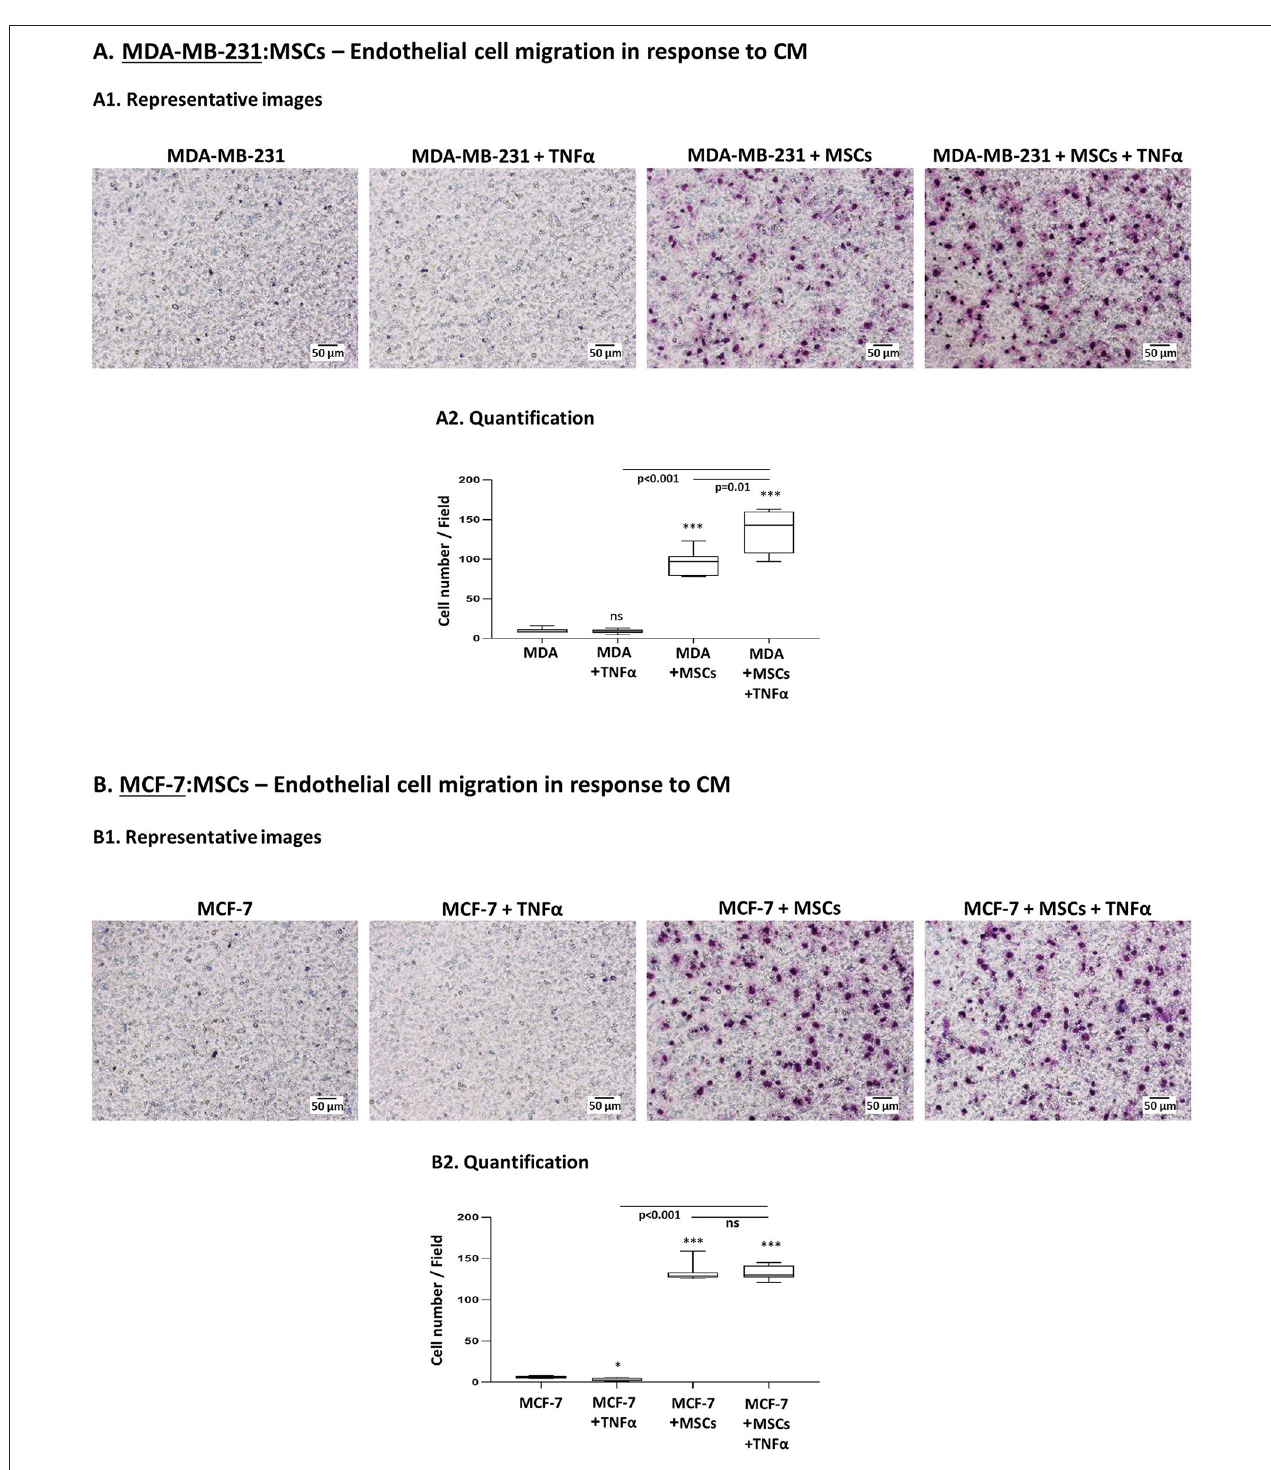
FIGURE 8 | The pro-angiogenic activities of factors released by tumor:MSC “Contact” co-cultures are promoted by TNF α in TNBC but not in luminal-A cells. Studies of endothelial cell (HPMEC) migration in response to CM derived from different cell combinations of MDA-MB-231 cells (“MDA”) (A) and MCF-7 cells (B) . (A1, B1) Representative photos of HPMEC migration in response to TNF α -free CM derived from TNF α -stimulated tumor:MSC “Contact” co-cultures (10ng/ml), from tumor cells alone, from tumor cells stimulated by TNF α alone and from tumor cells grown under “Contact” conditions with MSCs only. Bars, 50 µ m. (A2, B2) Migrated HPMEC were counted in multiple photos per insert of the experiments presented in A1 and B1. *** p < 0.001, * p < 0.05, ns = non-significant for comparisons between CM of different cell combinations and CM of tumor cells treated by vehicle. Photos and their quantifications are representatives of n ≥ 3 independent experiments, performed with MSCs of 3 different